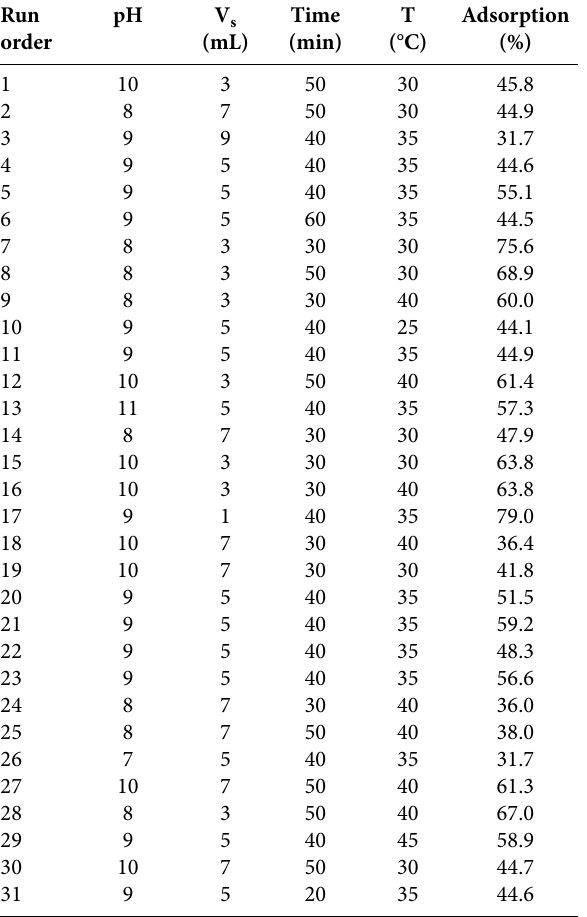
Table 2. Conditions of the performed tests and their related adsorp- tion efficiency attained by the experiments in the CCD optimiza-